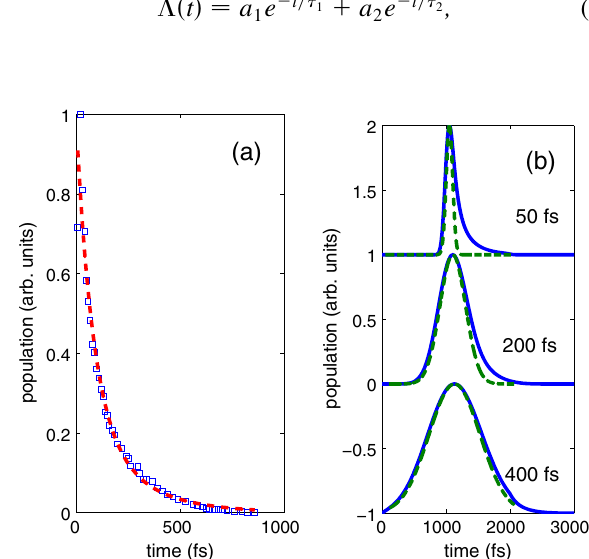
FIG. 4. Monte Carlo simulation (squares) taken from Ref. [39] and parametrization (dashed line) of the electron transit time from an initial Dirac-like laser excitation (a). Impact of the slow response time on the photoemission profile (blue traces) for three different Gaussian-like laser profiles (green dashed traces) of indicated rms duration (b). The traces in plot (b) are vertically offset for clarity. Larger time ordinates correspond to the bunch